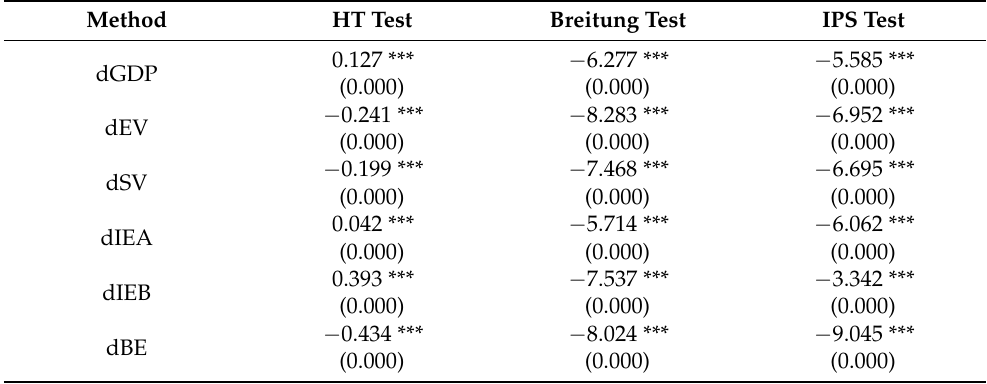
Table 3. Table Unit root test of variables.